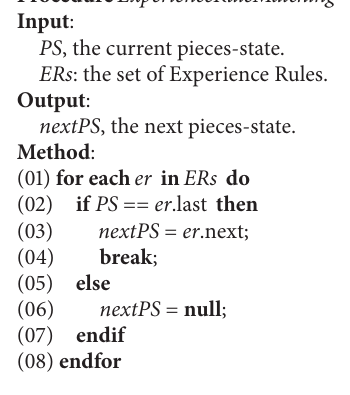
Table 4: Data records of the test in human-computer mode without any experiential